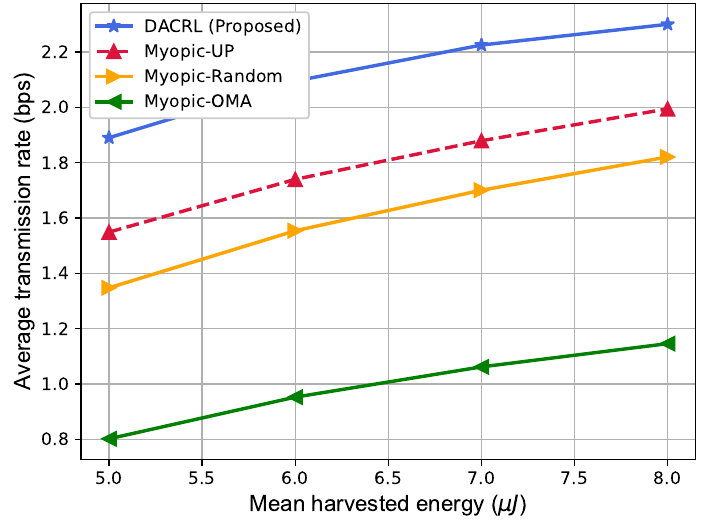
Figure 10. Average transmission rate according to different values for mean harvested